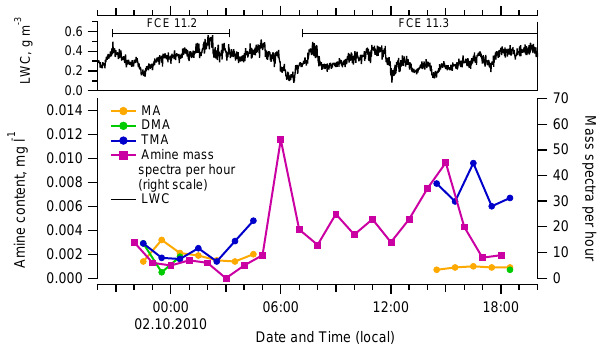
Figure 7. Time series (LT) of the amine compounds methylamine (MA), dimethylamine (DMA), and trimethylamine (TMA) from cloud water samples on 2 October 2010 (FCE11.2 and FCE 11.3) compared to the time series (number of mass spectra per hour) of amine-containing cloud residues. The upper panel shows the liquid water content (LWC) and the FCE